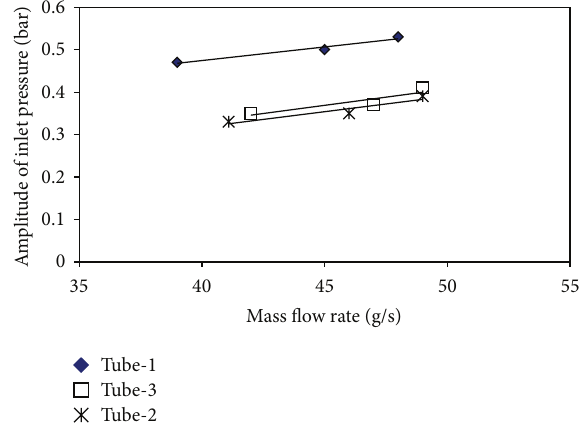
F 13: e variations in the amplitudes with the mass �ow rate for all tubes (p. d.